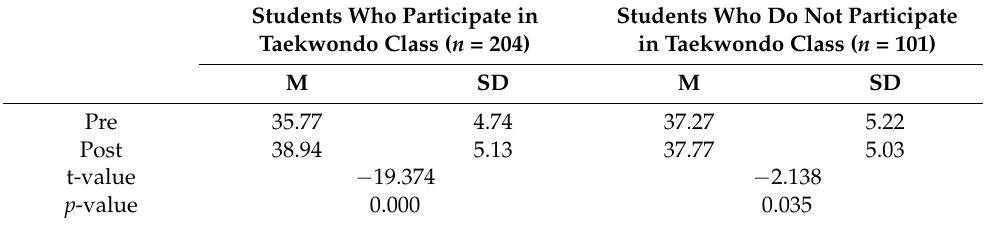
Table 1. Changes in GRIT of participants and non-participants.